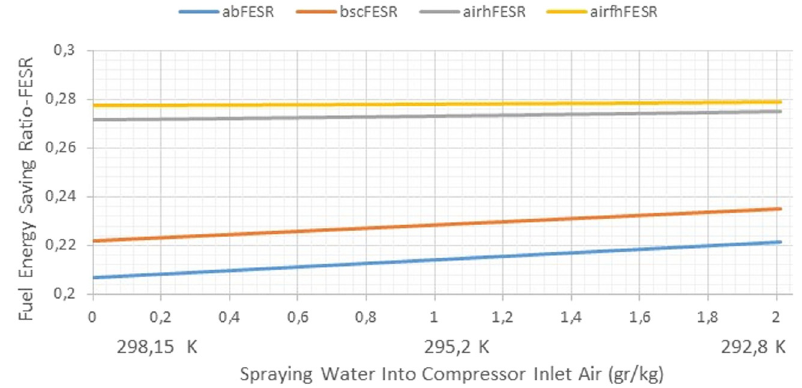
Figure 14: Variation of the FESR with spraying water into compressor inlet air ( g/kg ) for ab, bsc, airh, and airfh cogeneration systems.